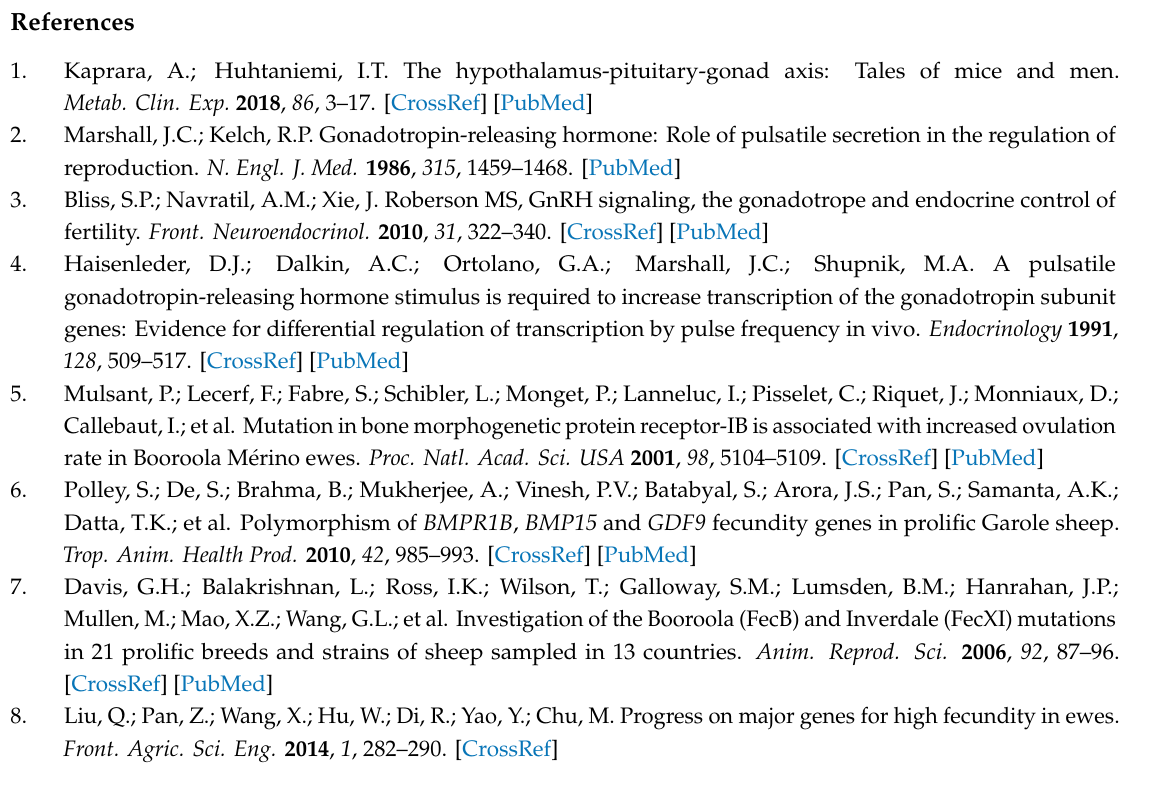
Target genes of oar-miR-665-3p predicted by TargetScan